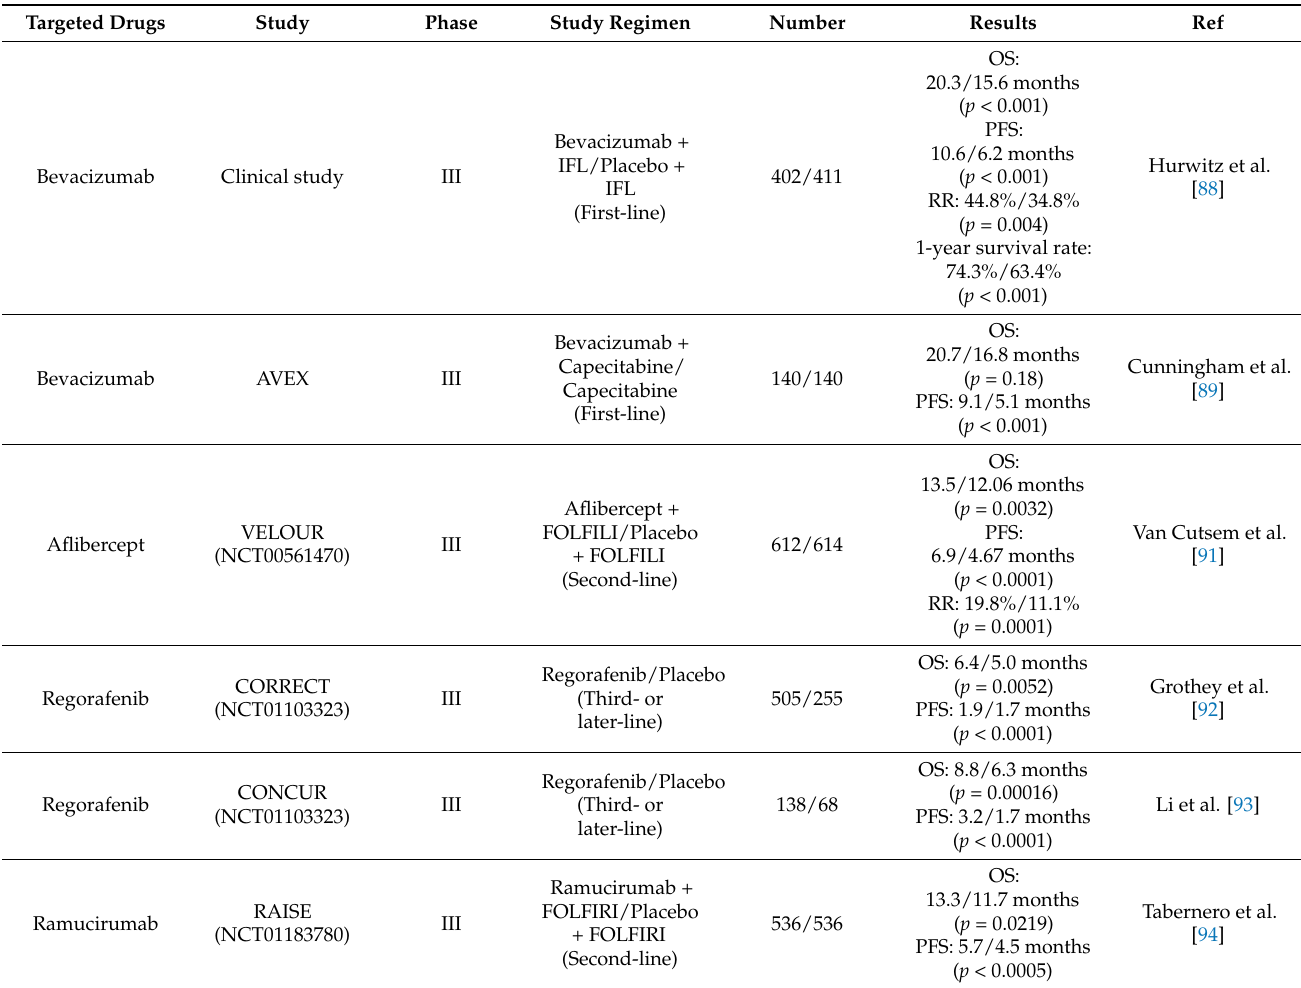
Table 3. Selected clinical trials for VEGF/VEGFR-targeting